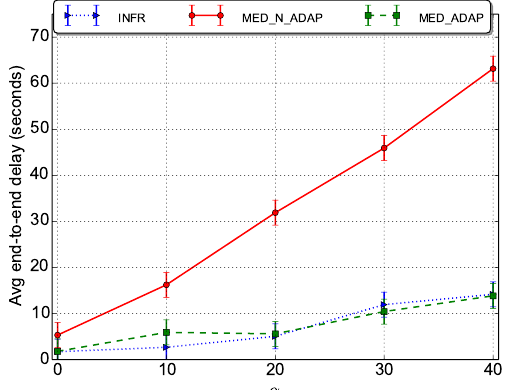
Figure 8. Average end to end delays per data packet.